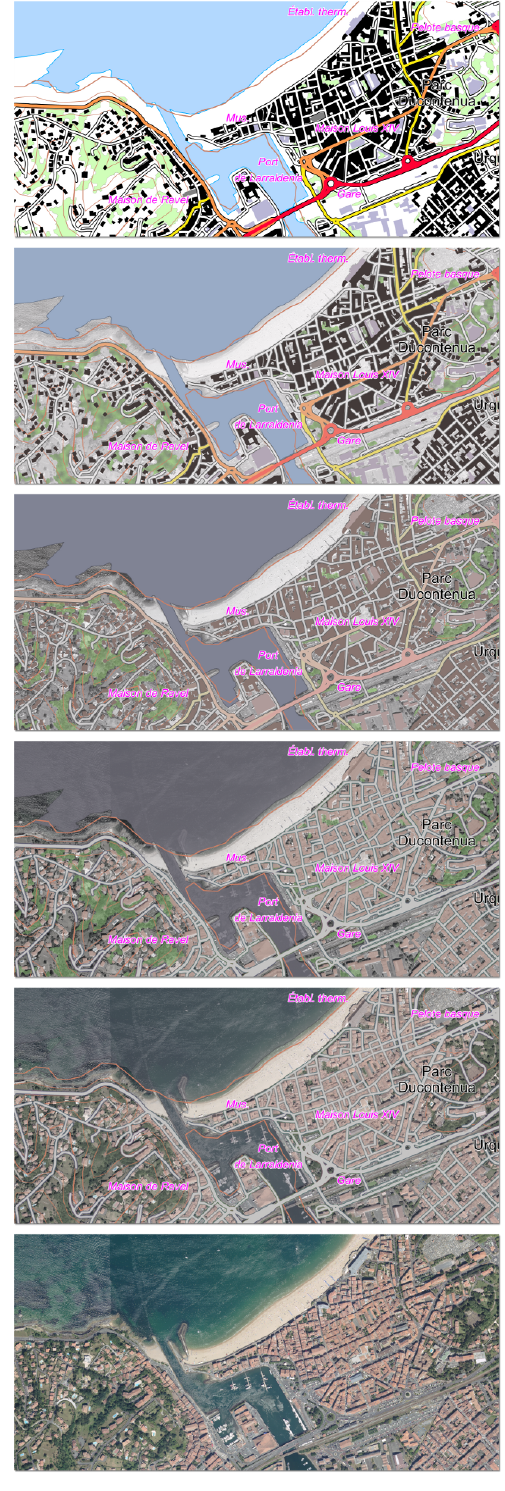
Figure 16: Final geovisualizations forming a continuum between a map and an imagery.